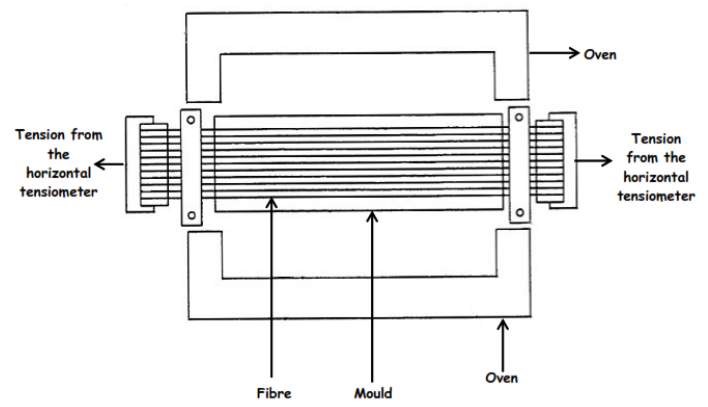
Figure 8. Schematic representation of a horizontal tensile machine.